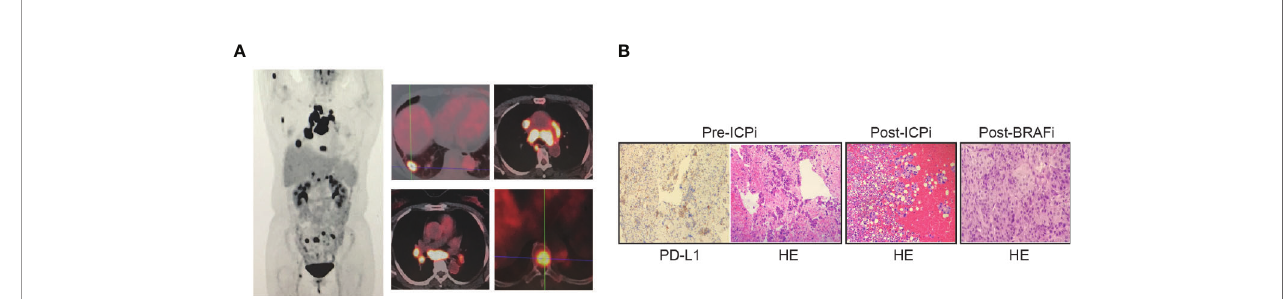
FIGURE 1 | PET/CT imaging and histological fi nding. (A) PET/CT imaging on 2018/03/19 revealed an enlarged nodule measuring 2.0 × 1.6 cm on right lower lobe (RLL) with SUVmax 8.4, bilateral supraclavicular lymph nodes (0.5 cm and 0.6 cm on the right and left sides respectively) with SUVmax 2.8, enlarged mediastinal lymphadenectases including station 2R, 4R, 4L, 3A, 3P, 5, 6, 7, and right hilar lymphadenectasis with SUVmax 26.4 of the largest diameter of 4.2 cm, multiple bony metastases including right humerus, right scapula, T5 and T8 vertebral body, multiple sacrum, right acetabulum, right sciatic bone with a SUVmax 7.8. (B) Histological examination on the metastatic subcarinal lymphadenectasis tissue of pre-ICPi ( fi rst-biopsy), pericardial effusion of post-ICPi/pre-BRAFi (second- biopsy), and left supraclavicular lymphadenectasis of post-BRAFi (third biopsy) (hematoxylin and eosin stain, magni fi cation ×100) and programmed death ligand-1 (PD-L1) expression in pre-ICPi (immunohistochemical stain, magni fi cation ×100; E1L3N, Cell Signaling Technology, Danvers, MA); poorly differentiated lung adenocarcinoma positive for CK, TTF1, and NapsinA, negative for CD56 and P40 by immunohistochemistry stain in pre-ICPi (03/28/2018), post-ICPi/pre-BRAFi (12/ 20/2019), and post-BRAFi (06/04/2020). ICPi, immune check-point inhibitor; BRAFi, BRAF